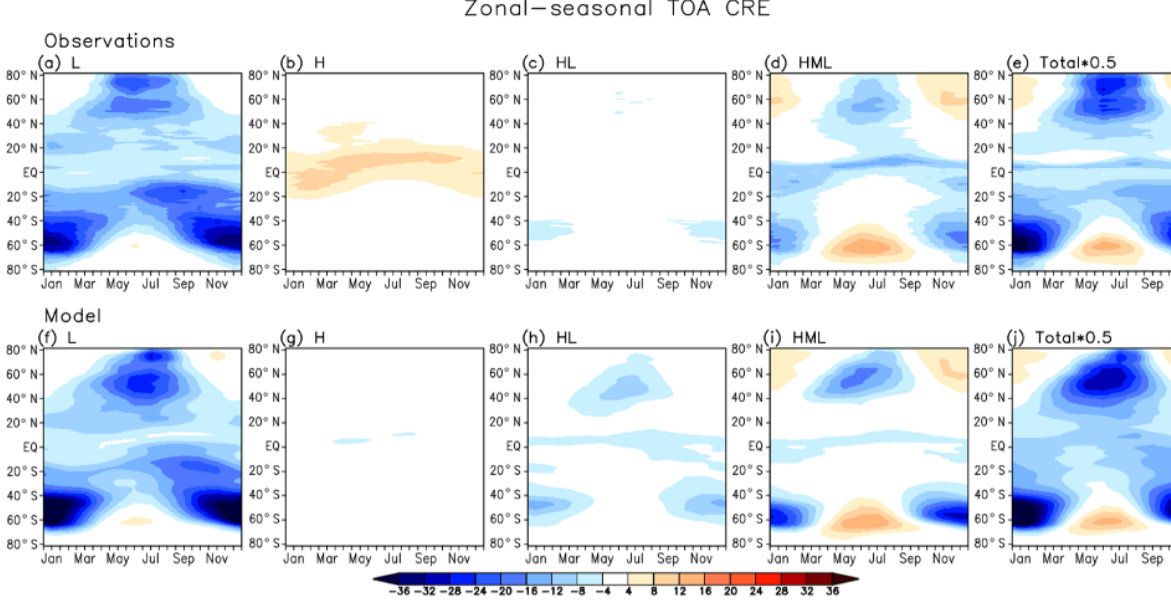
Figure 7. Comparison of the multiyear annual cycle of TOA total (SW + LW) all-sky CRE zonal averages (Wm − 2 ) between observations (top row, panels a to e ) and the model (bottom row, panels f to j ) when employing the GN overlap assumption for the four CVS classes with the greatest all-sky CREs according to Fig. 5. The rightmost panels displays the scaled (half) total CRE of all CVS classes